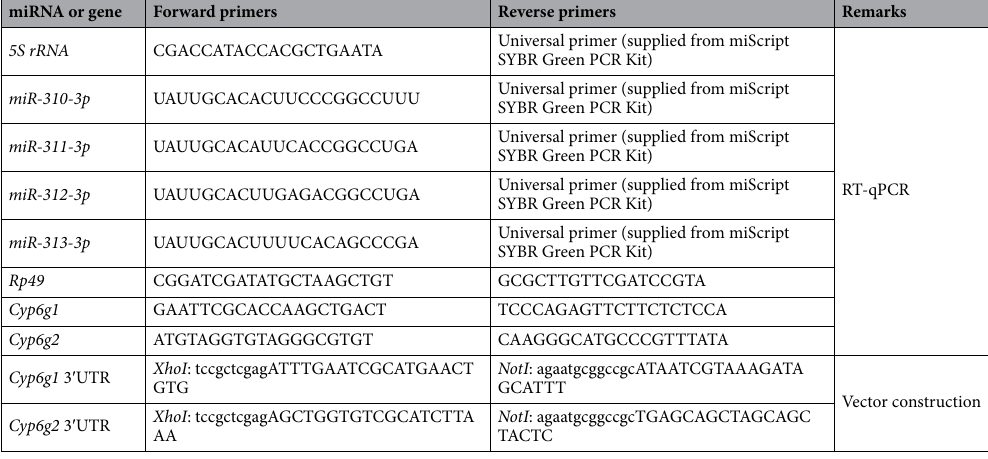
Table 2. Sequences of the primers used in this